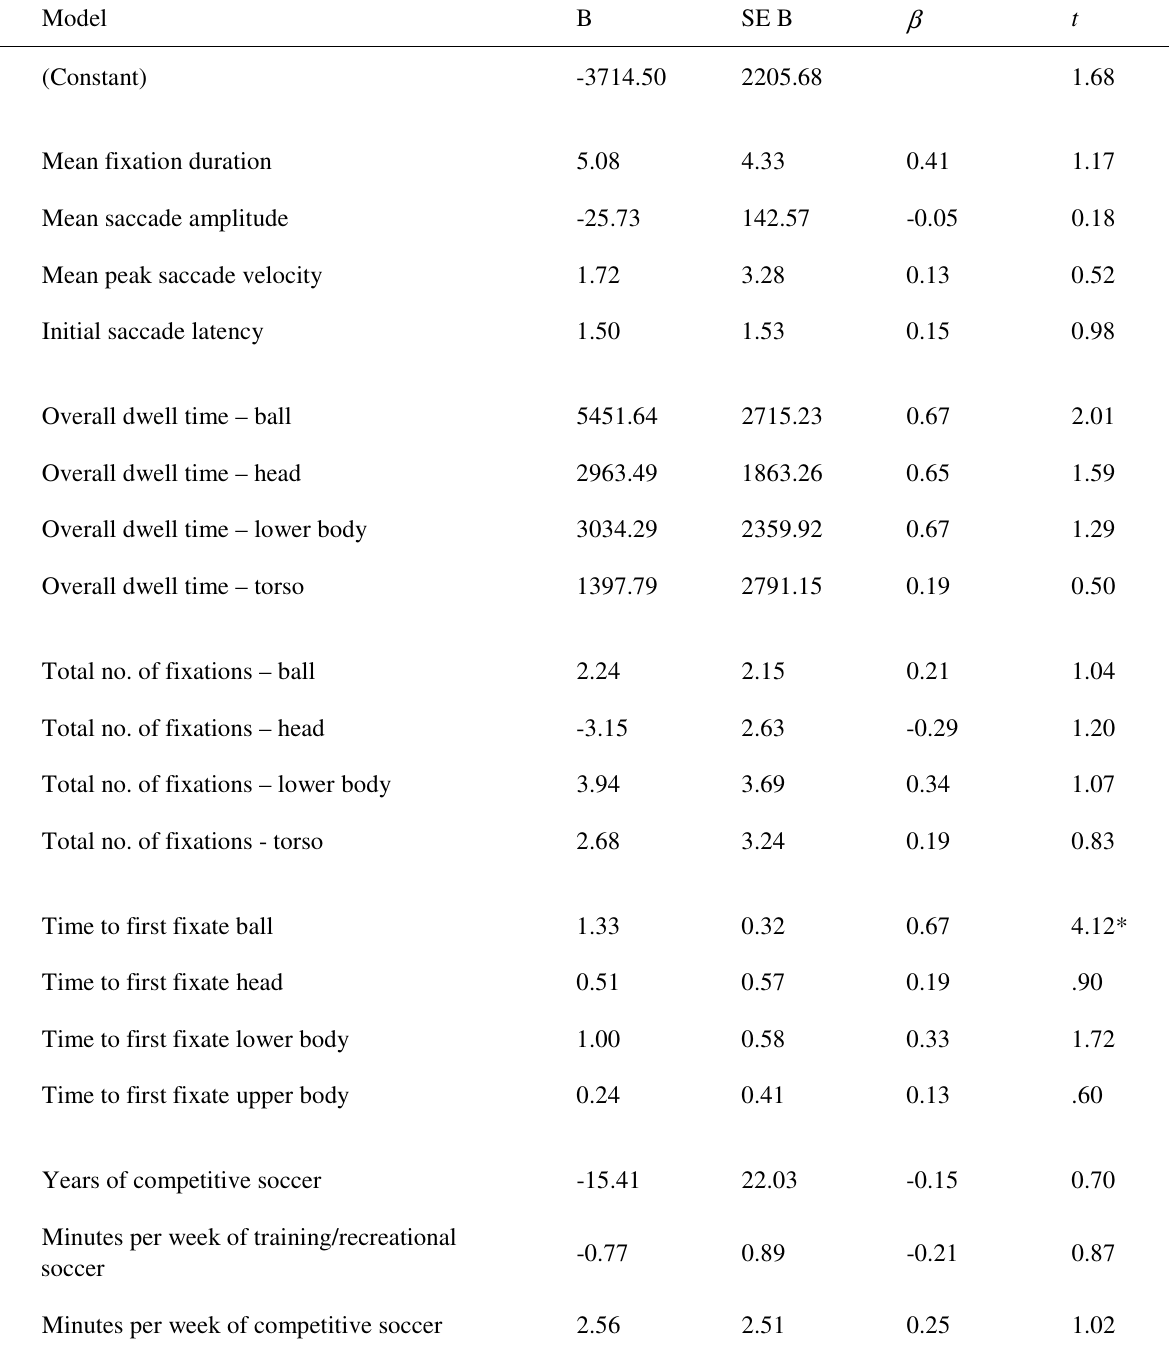
Table 1 Beta coefficients and t values for all